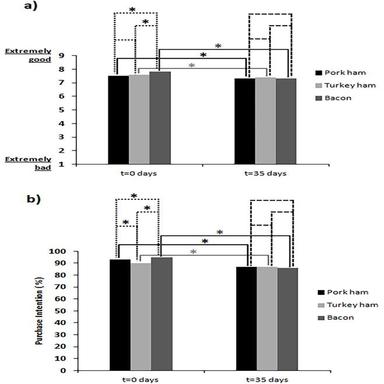
a) Global product appreciation results at t = 0 days and t = 35 days to the three meat products (scale is 1 to 9, where 1 means extremely bad and 9 means extremely good). b) Purchase intention of the three meat product at t = 0 days and t = 35 days. \Significance at p ≤ 0.05.